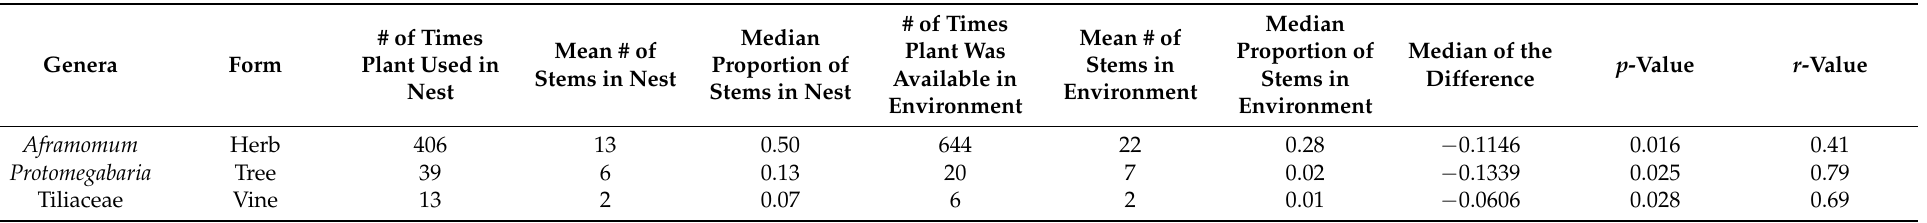
Table 7. Mean and median number of nest stems and proportion of the preferred plant genera within night nests constructed by gorillas and the two-metre radius around the nest.